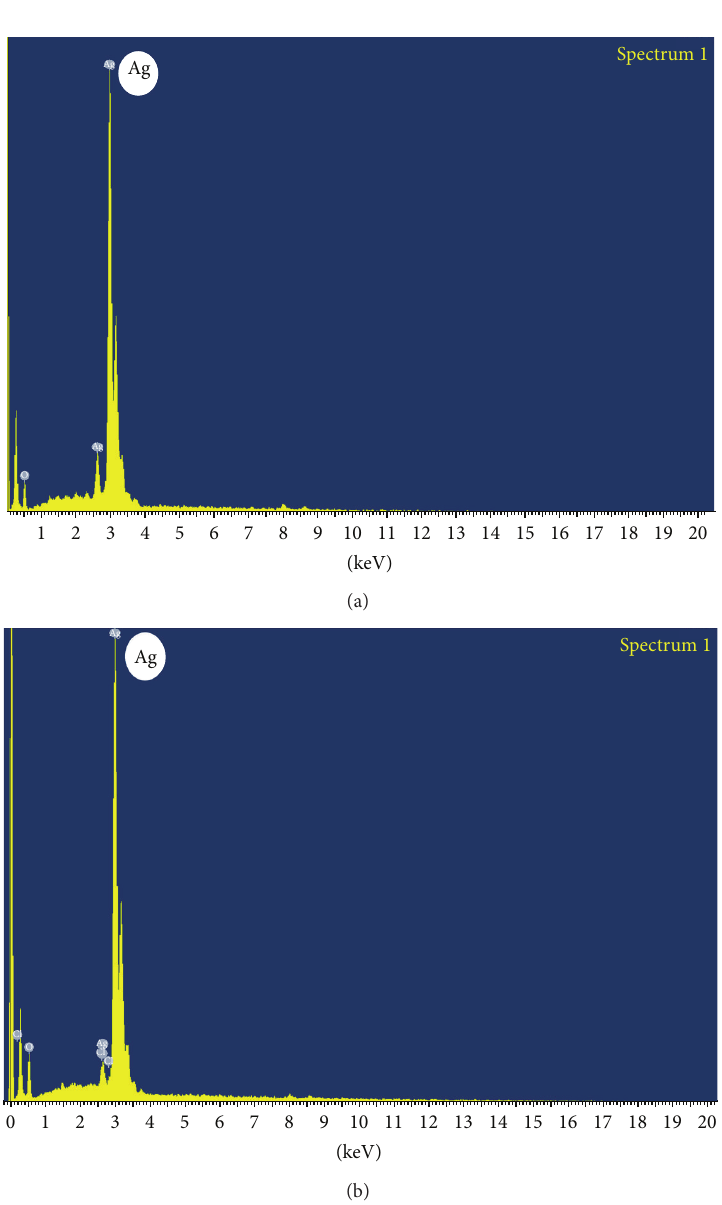
Figure 6: EDAX spectra of silver nanoparticles synthesized by using leaf (a) and stem extract (b) of Piper